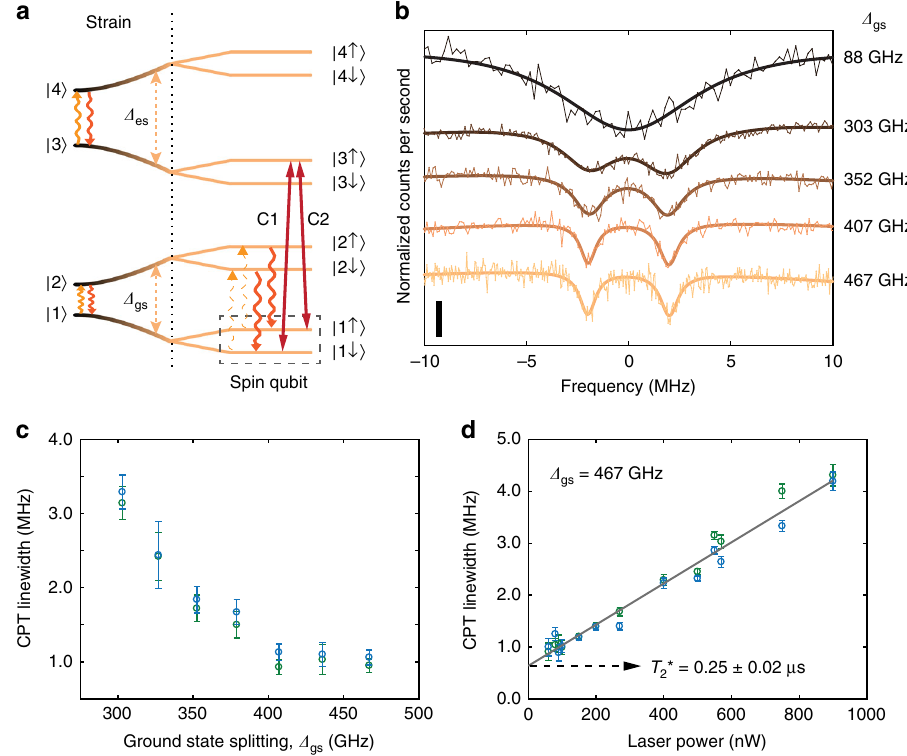
Fig. 3 Spin coherence measurements. a SiV − level structure in the presence of strain and external magnetic fi eld. A spin qubit is de fi ned with levels 1 #j i and 1 "j i on the lower orbital branch of the GS. This qubit can be polarized, and prepared optically using the Λ -scheme provided by transitions C1 and C2. Phonon transitions within ground- and excited-state manifolds are also indicated. The upward phonon transition (phonon absorption process) can be suppressed at high strain, thereby mitigating the effect of phonons on the coherence of the spin qubit. b Coherent population trapping (CPT) spectra probing the spin transition at increasing values of the GS orbital splitting Δ gs from top to bottom. Scale bar in bottom left represents a fl uorescence signal contrast of 10%. Measurements are carried till the noise in the fl uorescence signal is below 1.5%. Bold solid curves are Lorentzian fi ts. Optical power is adjusted in each measurement to minimize power-broadening. c Linewidth of CPT dips as a function of GS orbital splitting Δ gs indicating improvement in spin coherence with increasing strain. Error bars represent standard deviation of the estimated linewidths from the Lorentzian fi ts. d Power dependence of CPT-linewidth at the highest strain condition ( Δ gs = 467 GHz). Data points are estimated linewidths from CPT measurements, and the solid curve is a = 0.25 ± 0.02 μ linear fi t, which reveals a linewidth of 0.64 ± 0.06 MHz corresponding to T (cid:2) 2